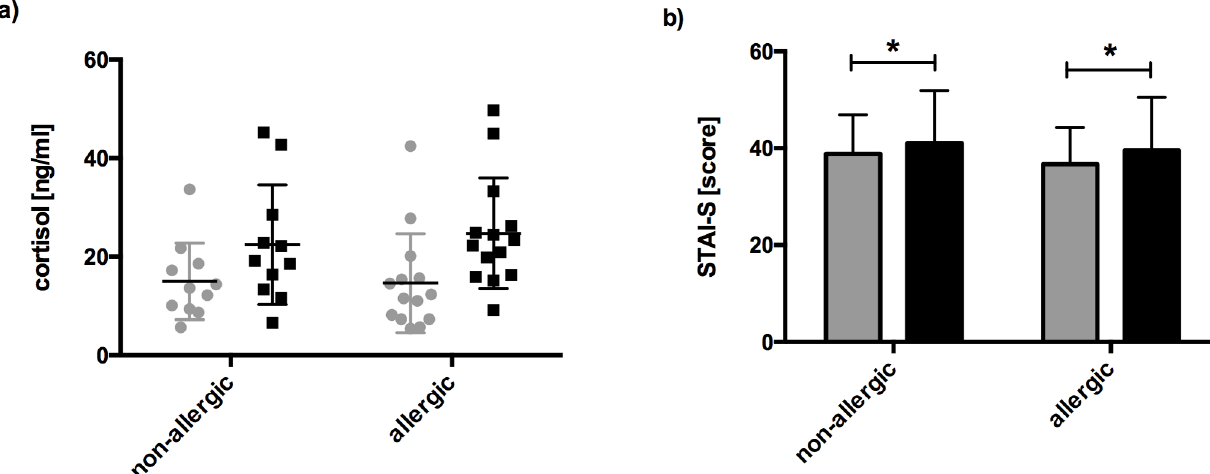
Fig 2. Verification of TSST-induced stress in study subjects. a) Salivary cortisol (means ± SD, ng/ml) in allergics (n = 14) and non-allergics (n = 11) who responded after the TSST; grey data points before, black after TSST; b) results of State-Trait-Anxiety Inventory (STAI-S) for self-reported anxiety in allergic (n = 20) and non-allergic participants (n = 19) before (grey boxes) and after the TSST (black boxes) (means ± SD); (cid:3)(cid:3)(cid:3) p (cid:20) 0.001. (cid:3) P (cid:20) 0.05.